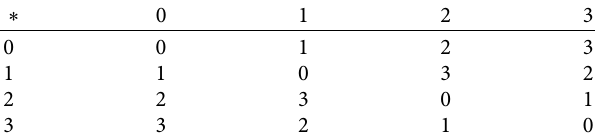
Table 3: Cayley table of the binary operation ∗